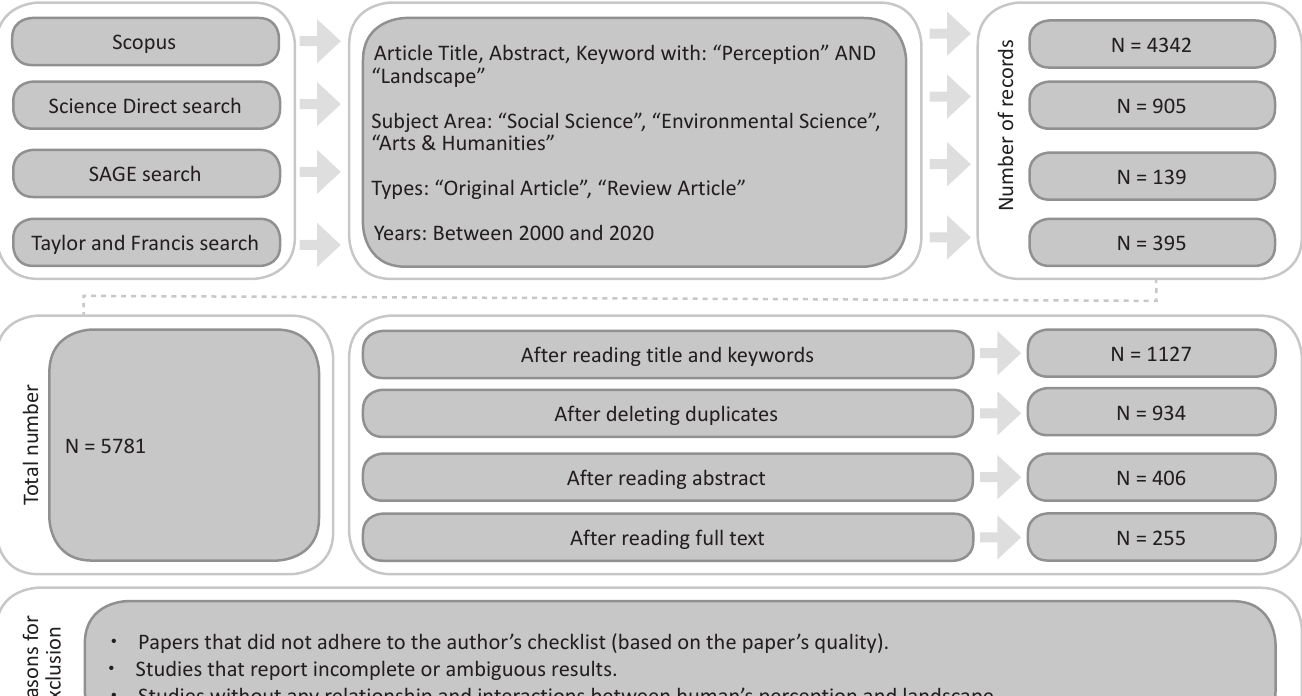
x Papers that did not adhere to the author’s checklist (based on the paper’s quality). x Studies that report incomplete or ambiguous results. x Studies without any relationship and interactions between human’s perception and